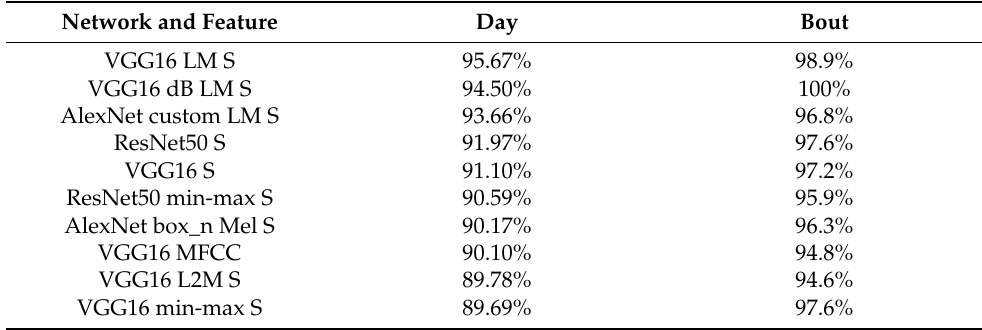
Table 1. Performance Accuracy of the Ten Best Single Networks on the ERR Day and ERR Bout Datasets.